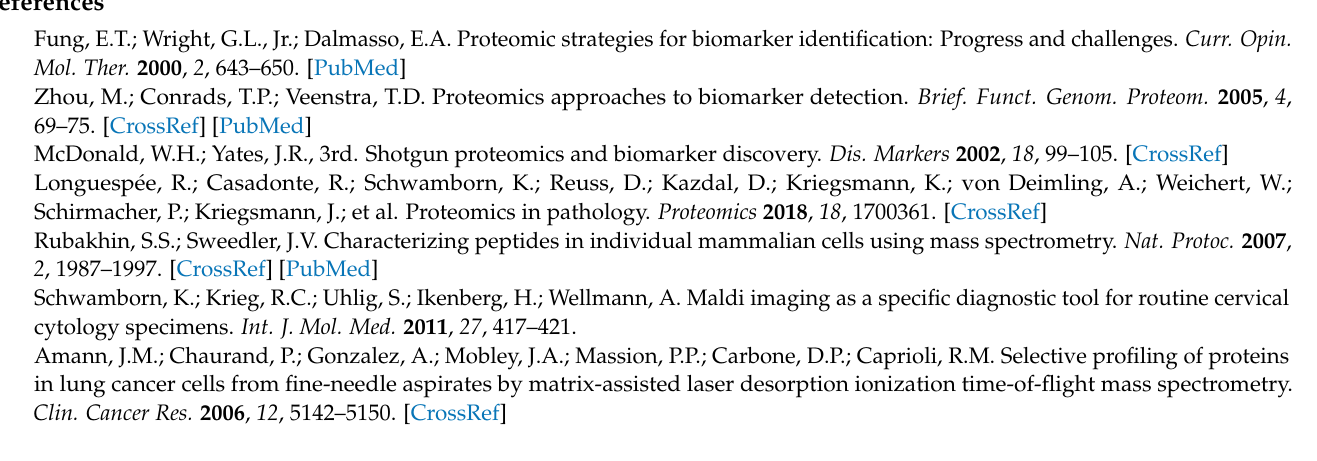
Figure S2: Peak intensity distribution in cytospin and FFPE samples through the m/z range 500–2000. Figure S3: Peptide profiles and principal component analysis (PCA) obtained from two FFPE cell blocks prepared with two automatic processing systems. Table S1: Sample paraffin processing protocol. Table S2: Comparison of peptide ions’ ( m/z ) intensity between cytospin and FFPE